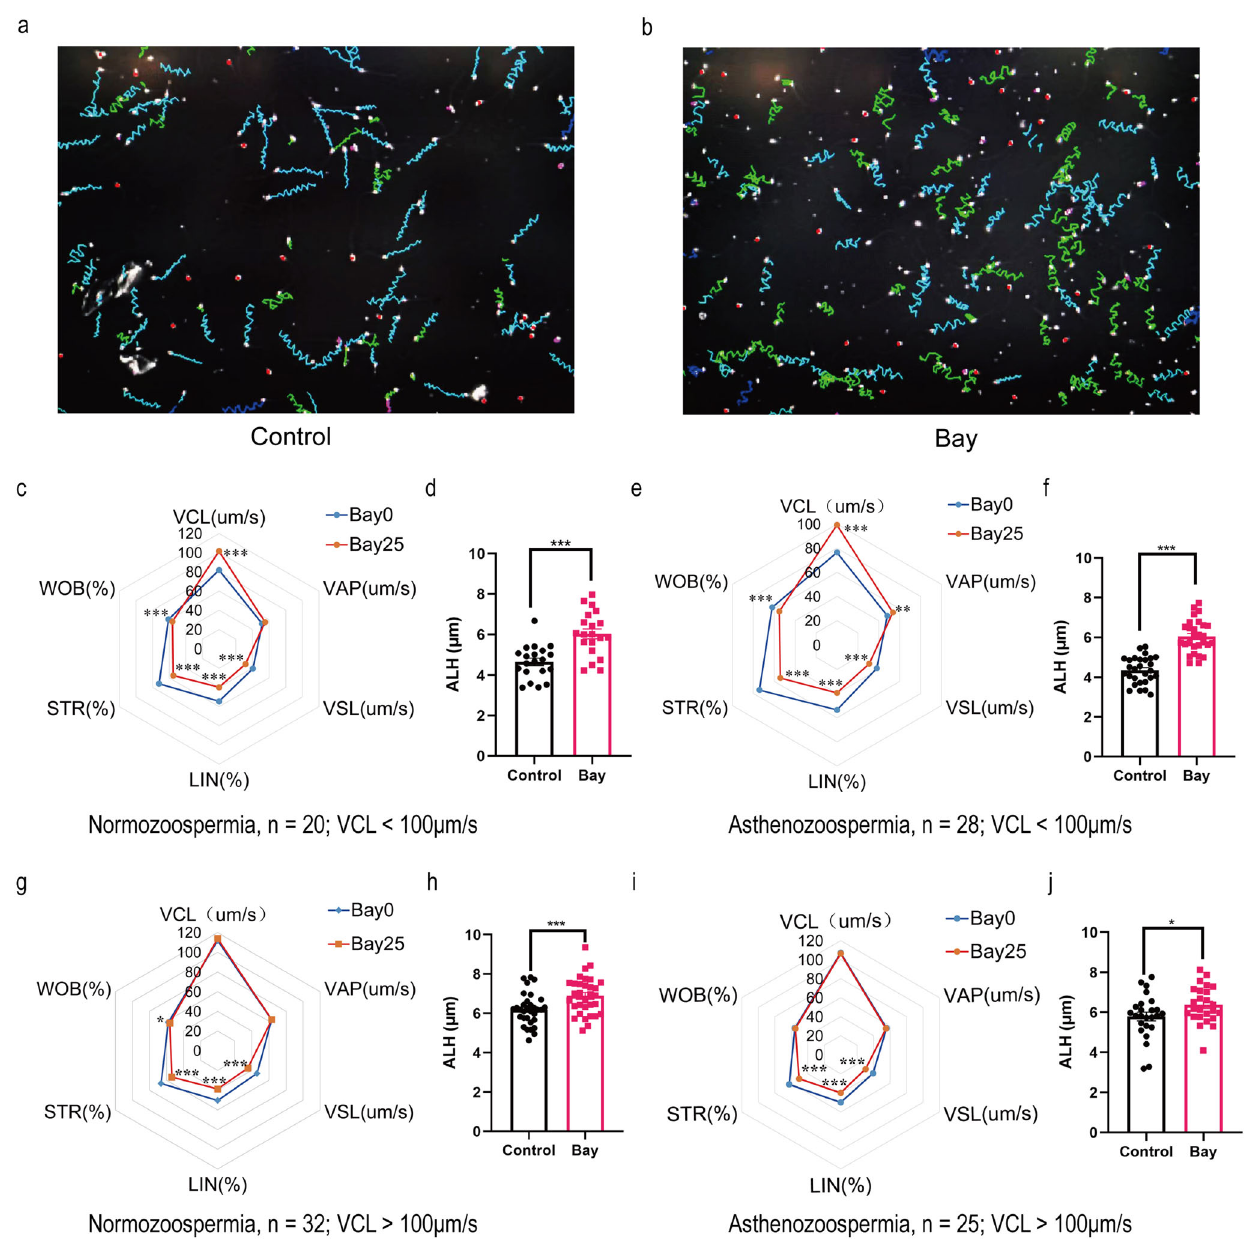
Fig. 3 I κ B α phosphorylation alters sperm swimming patterns from forward to curvilinear movement. a , b Sperm trajectories before ( a ) and after ( b ) treatment with 25 μ M Bay117082, as recorded by CASA. c – j Changes in sperm motility parameters after treatment with 25 μ M Bay117082 for 10 min. VCL, VAP, VSL, LIN, STR and WOB are presented in radar charts. ALH is shown in bar graphs. c – f Bay117082-induced changes in parameters related to the motility of normozoospermic ( c , d ) and asthenozoospermic ( e , f ) sperm, with basal VCL ≤ 100 μ m/s. g – j Bay117082-induced changes in parameters related to the motility of normozoospermic ( g , h ) and asthenozoospermic ( i , j ) sperm with basal VCL > 100 μ m/s. * p < 0.05; ** p < 0.01; *** p < 0.001, as compared with the control (0 μ